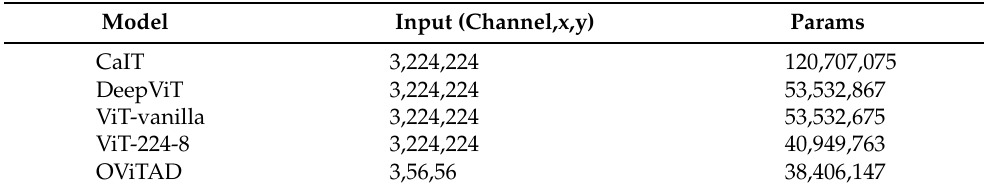
Table 4. The number of trainable parameters reduced by 28% compared to vanilla vision transformer and DeepViT while producing higher performance in fMRI and similar performance to other models in structural MRI data.